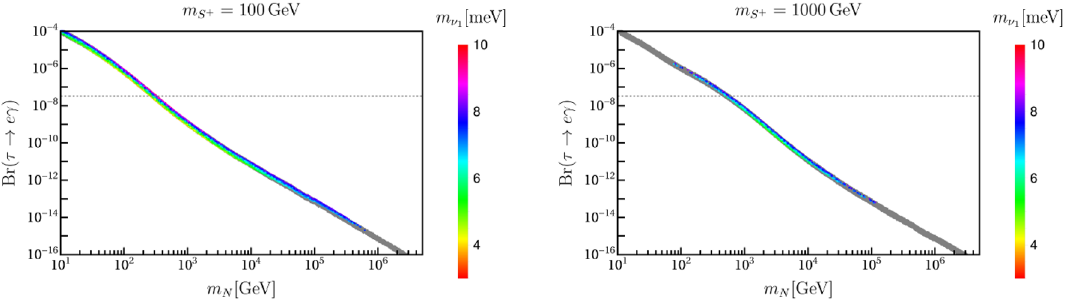
Figure 16 . Calculated values for Br( (cid:28) we are maximizing the allowed parameter space in terms of (cid:11) 13 . For the gray points, at least one entry in Y is larger than 4 (cid:25)